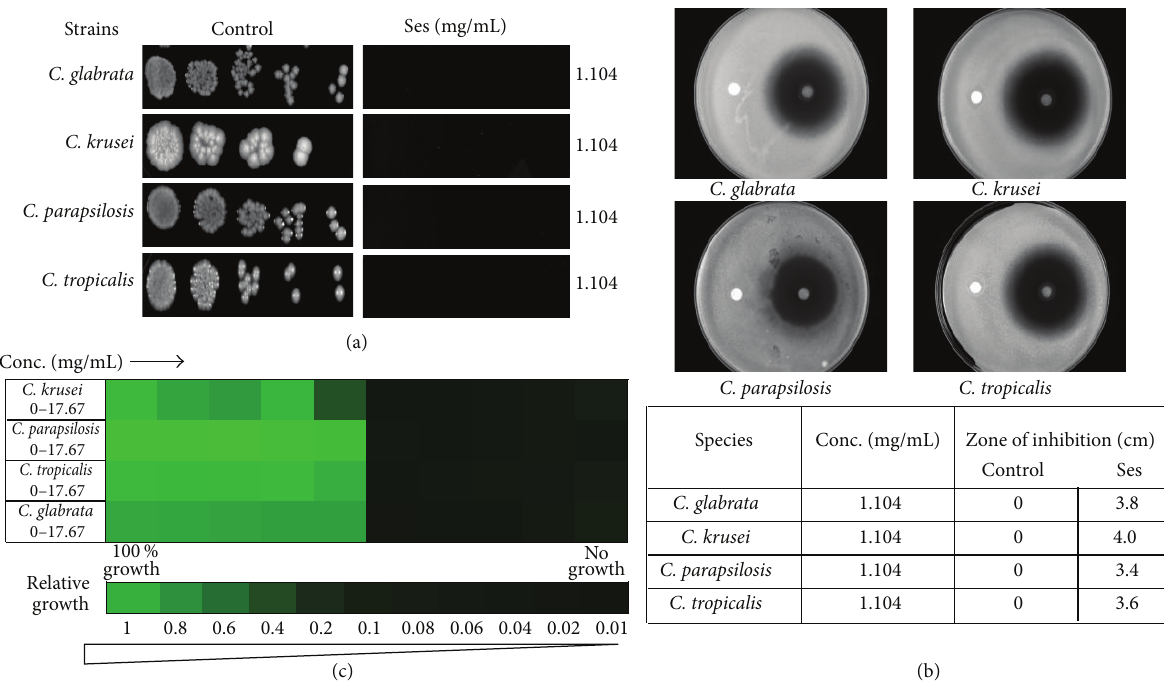
Figure 2: Drug susceptibility assays against non- albicans species of Candida in the presence of Ses. (a) Spot assay of C. glabrata, C. krusei , C. parapsilosis, and C. tropicalis , in the absence (control) and presence of Ses. (b) Disc diffusion assay against C. glabrata, C. krusei , C. parapsilosis , and C. tropicalis , and their respective zone of inhibitions in the absence (control) and presence of Ses. For control, discs were spotted with the solvent of Ses described in Section 2. (c) Broth microdilution assay to determine the MIC 80 of C. glabrata, C. krusei , C. parapsilosis, and C. tropicalis in presence of Ses. Data was quantitatively displayed with colour (see colour bar), where each shade of colour represents relative optical densities of the cell. The minimum drug concentration that inhibits growth by 80% relative to the drug-free growth control is indicated as MIC 80 for each strain.